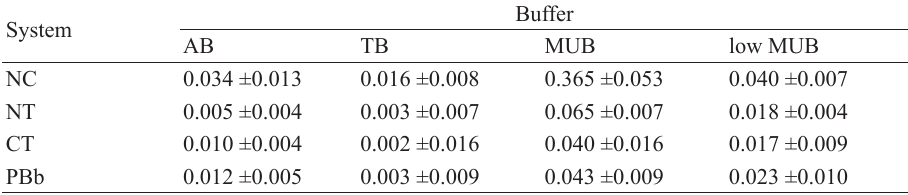
Absorbance values of control samples (without substrate) in each buffer 1 and agricultural systems 2